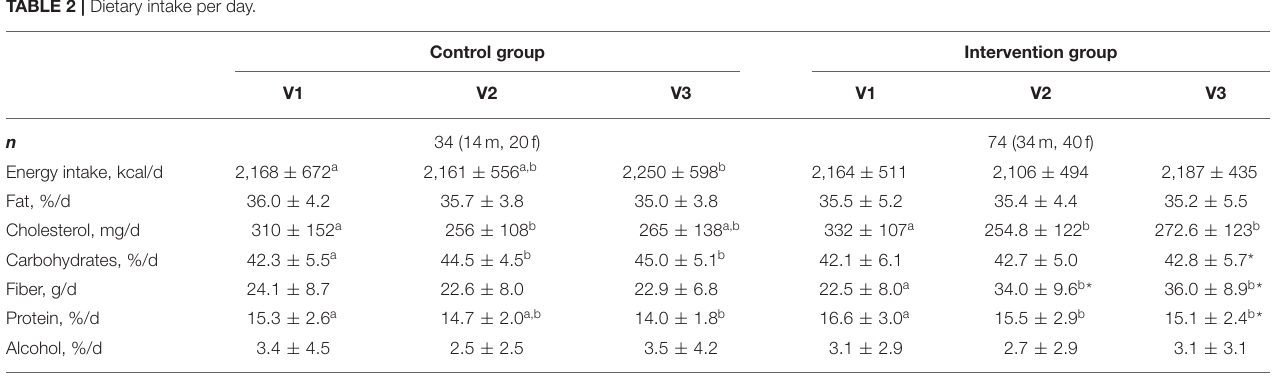
TABLE 2 | Dietary intake per